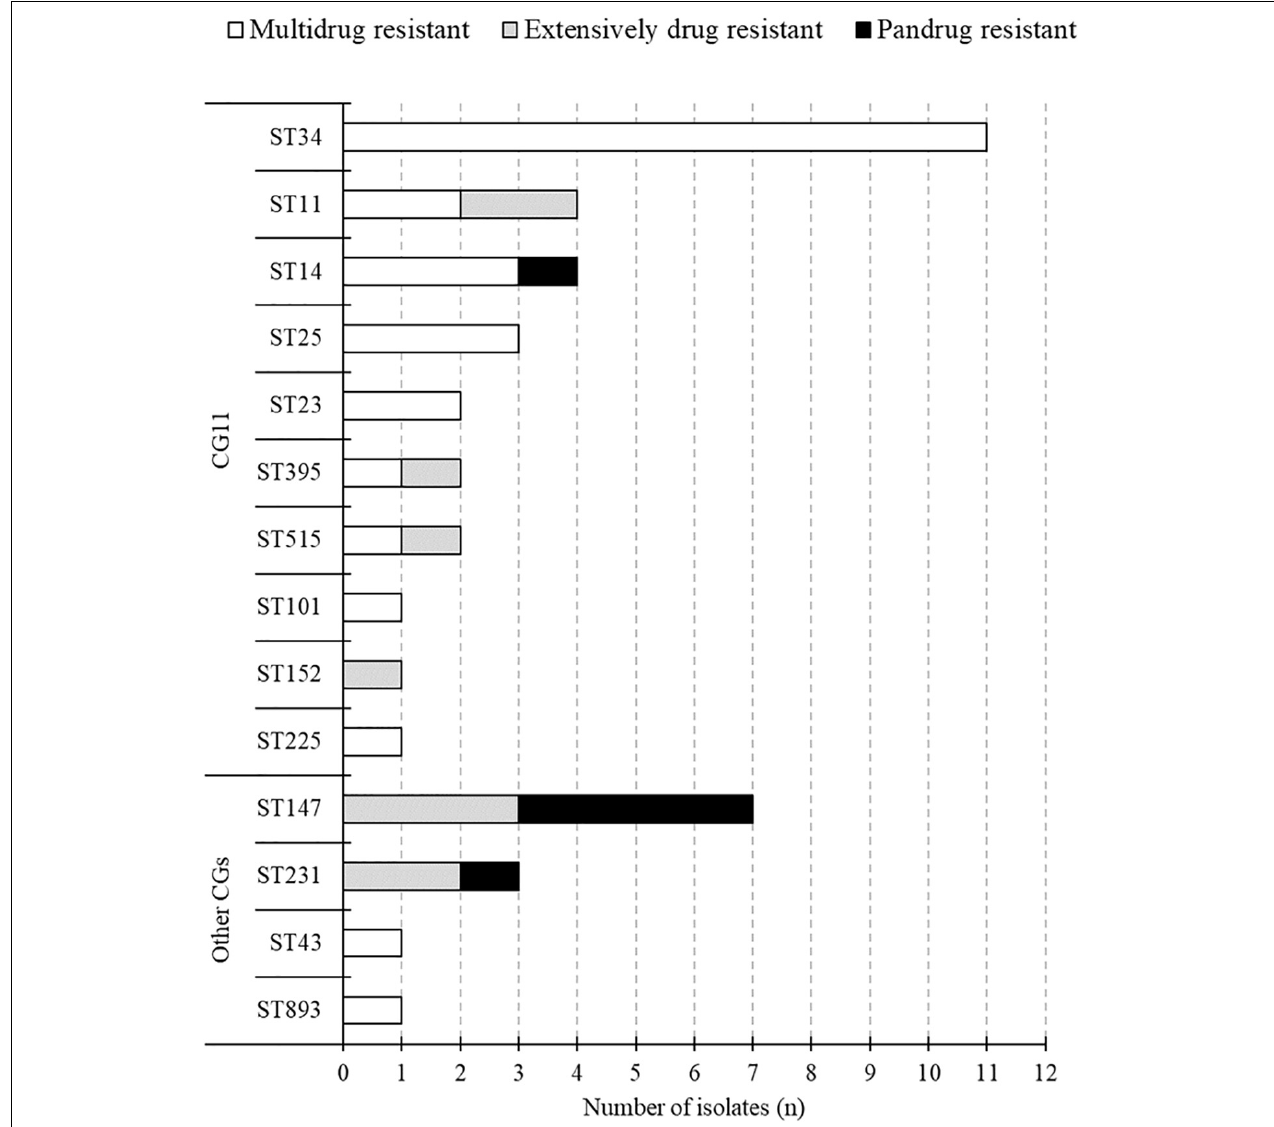
FIGURE 3 | Classification of multidrug resistance type of each